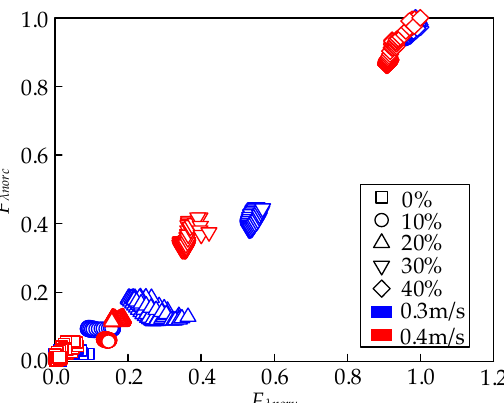
Figure 18. The distribution of the fault samples normalized by the MSN.